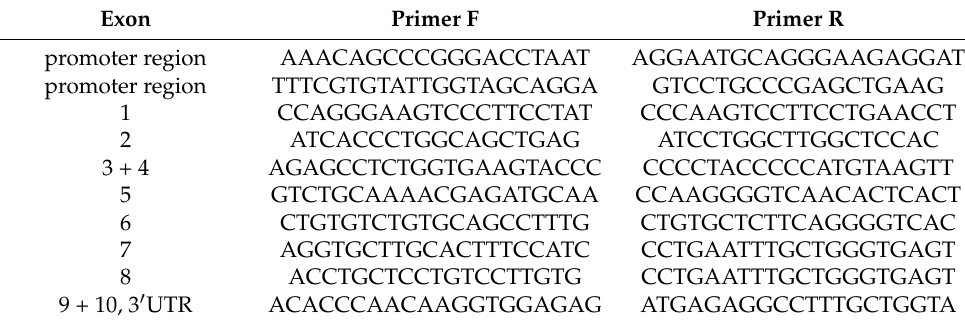
Table A2. Primers used for PCR and Sanger